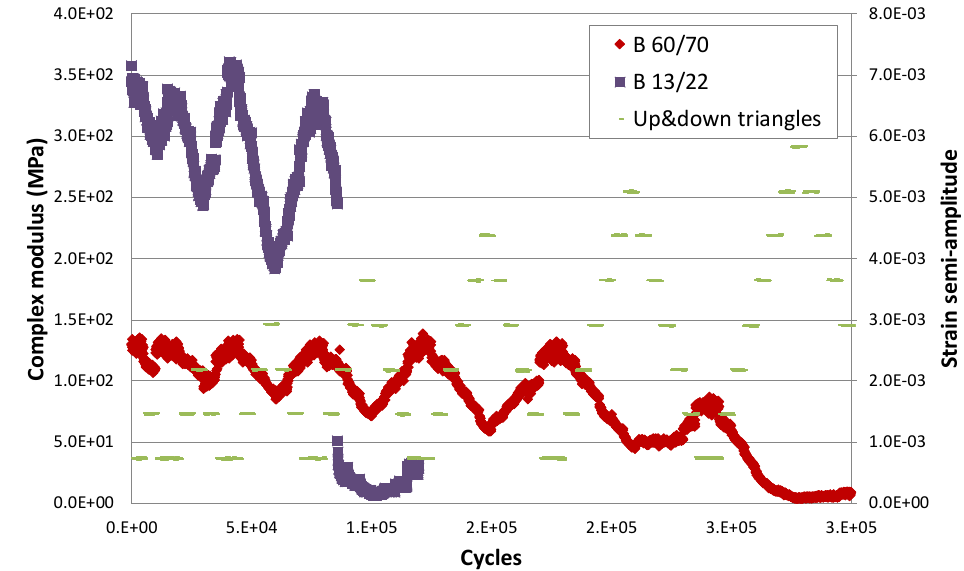
Figure 6. Complex modulus evolution with the number of cycles at 10 °C.